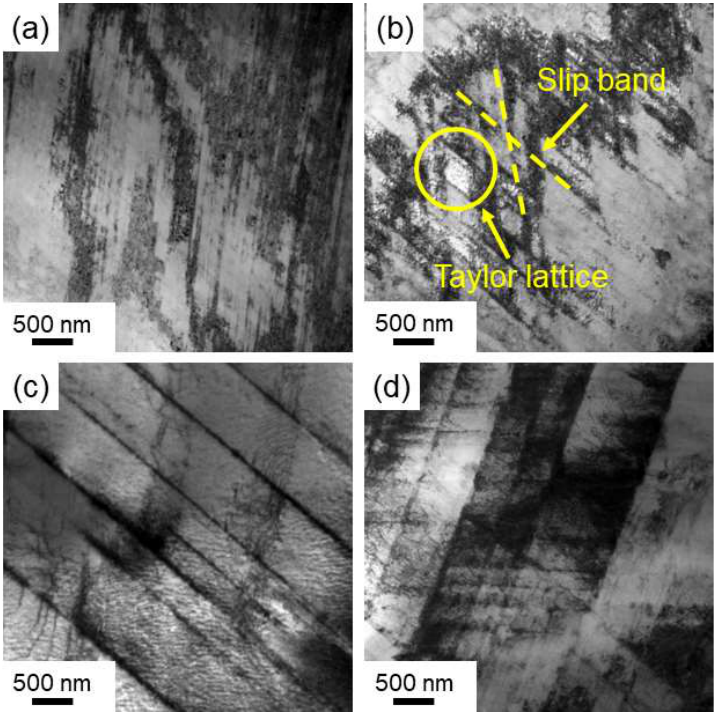
Figure 6. TEM images of ( a ) S1000, ( b ) A450, ( c ) A500 and ( d ) A550 specimens after stretching and deformation. and